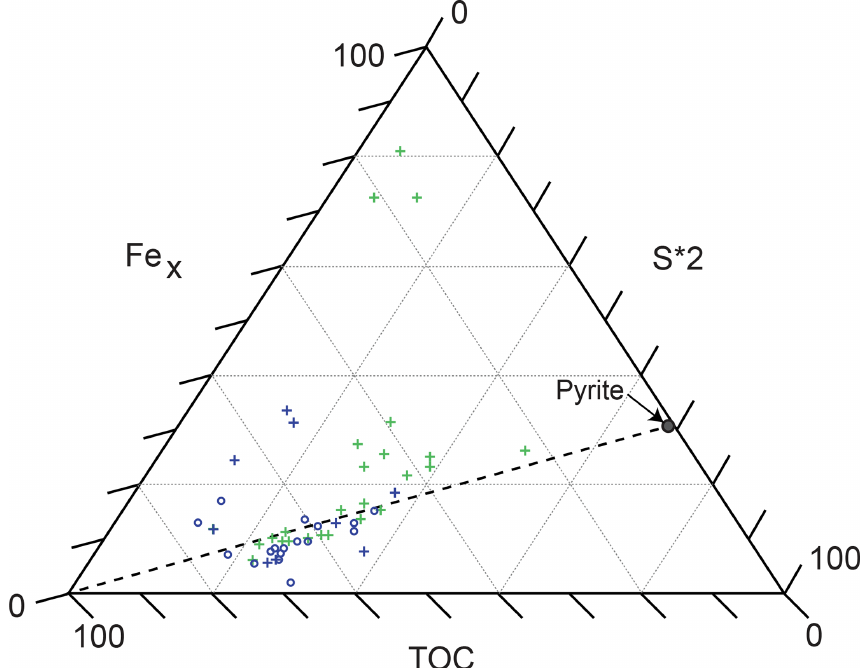
Figure 9. Fe x –TOC–S ternary diagram (after Dellwig et al., 1999; Hetzel et al., 2011). See the text for comments on Fe x calculation. The dashed line represents the TOC–pyrite mixing line. Lower-variability mudstone interval (LVMI) samples are indicated by green crosses (the three samples nearest to the Fe x corner represent the diagenetically overprinted samples that were excluded from the interpretation). Higher-variability mudstone interval (HVMI) samples are marked by blue symbols, TOC-rich samples (TOC > 10wt%) are indicated by blue circles, and TOC-lean samples (TOC < 10wt%) are indicated by blue crosses.